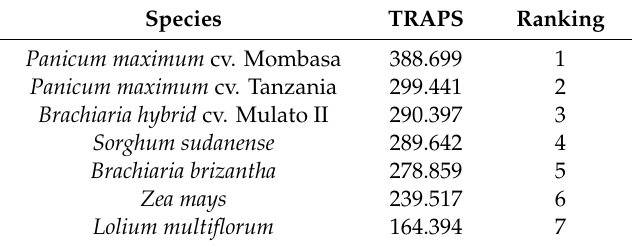
Table 5. Component loadings matrix for trap plants selection variables for S. frugiperda.